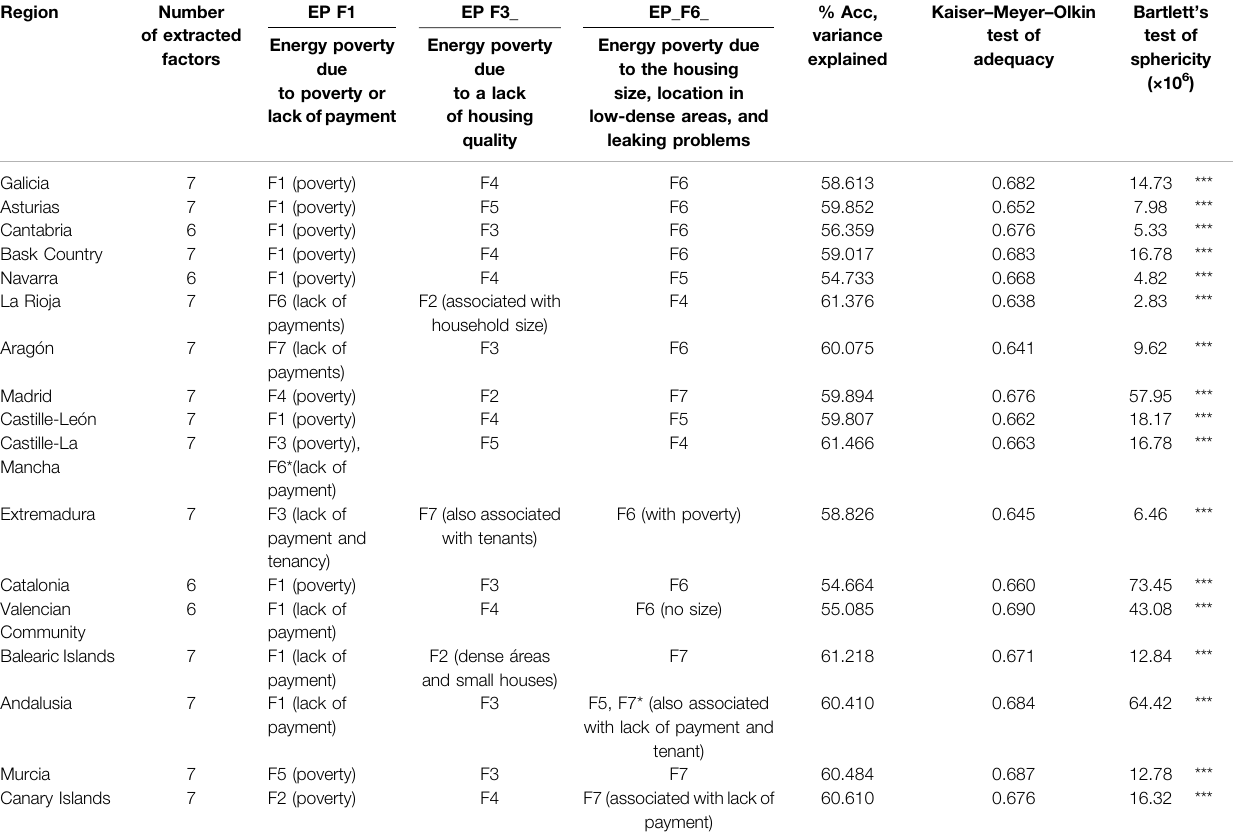
TABLE 4 | Energy poverty factor extracted by Spanish regions basic statistics. Region Number of